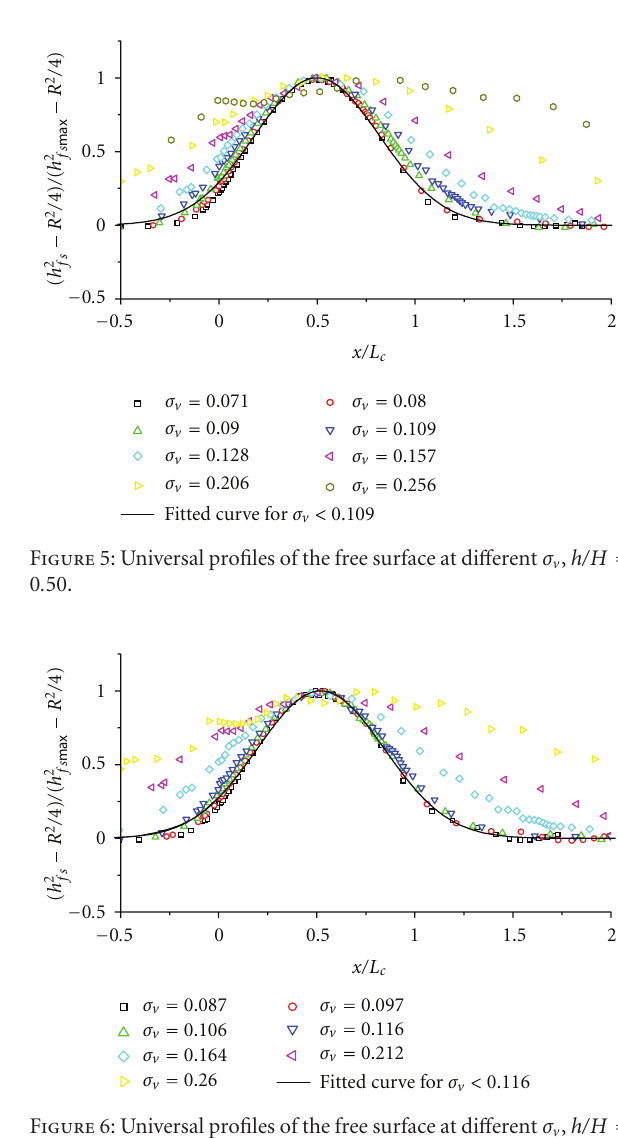
Figure 4: Universal profiles of the free surface at di ff erent σ v , h/H = 0 . 25.